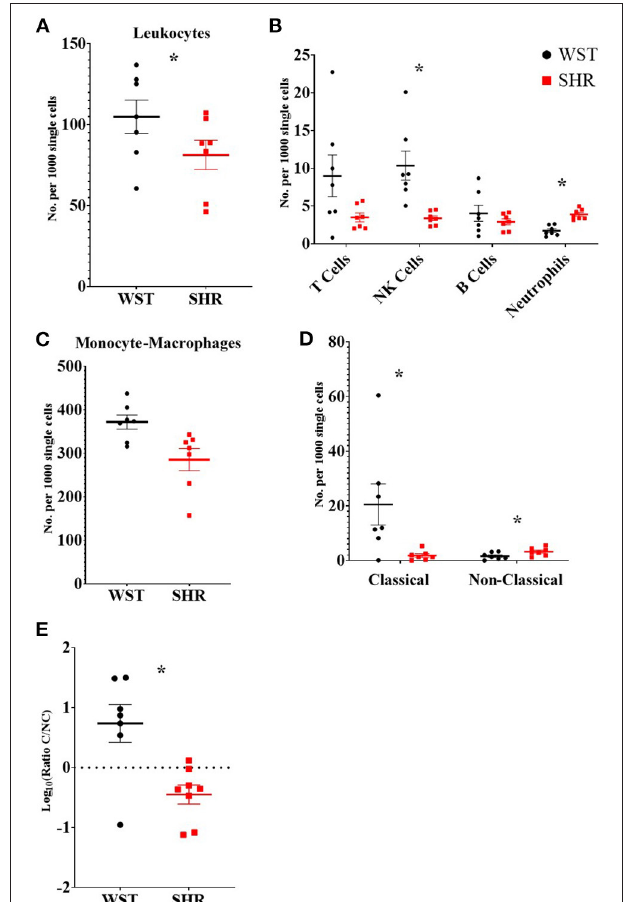
FIGURE 3 | Numbers of different leukocyte populations found within the stellate ganglia of 3-week old Wistar rats ( n = 7 samples, 2–3 rats per sample) and pre-SHRs ( n = 7 samples, 2–3 rats per sample). (A) Numbers of leukocytes. (B) Stratification of CD45 + cells into major leukocyte populations; monocyte-macrophages shown in (C) . (D) Classical and non-classical monocytes-macrophages. (E) Ratio of classical/non-classical monocyte-macrophages. In (A–D) the values are expressed as numbers per 1,000 single cells to allow comparison between samples which contained a different total number of cells. In (E) the ratio is presented as log 10 to allow visualization of the size of the ratio in either direction. Data are expressed as mean ± SEM. * signifies p < 0.05 WST vs. SHR; normal data were analyzed using Welch’s t-tests and multiple comparisons accounted for using q values determined by the two-stage set-up method of Benjamini, Krieger and